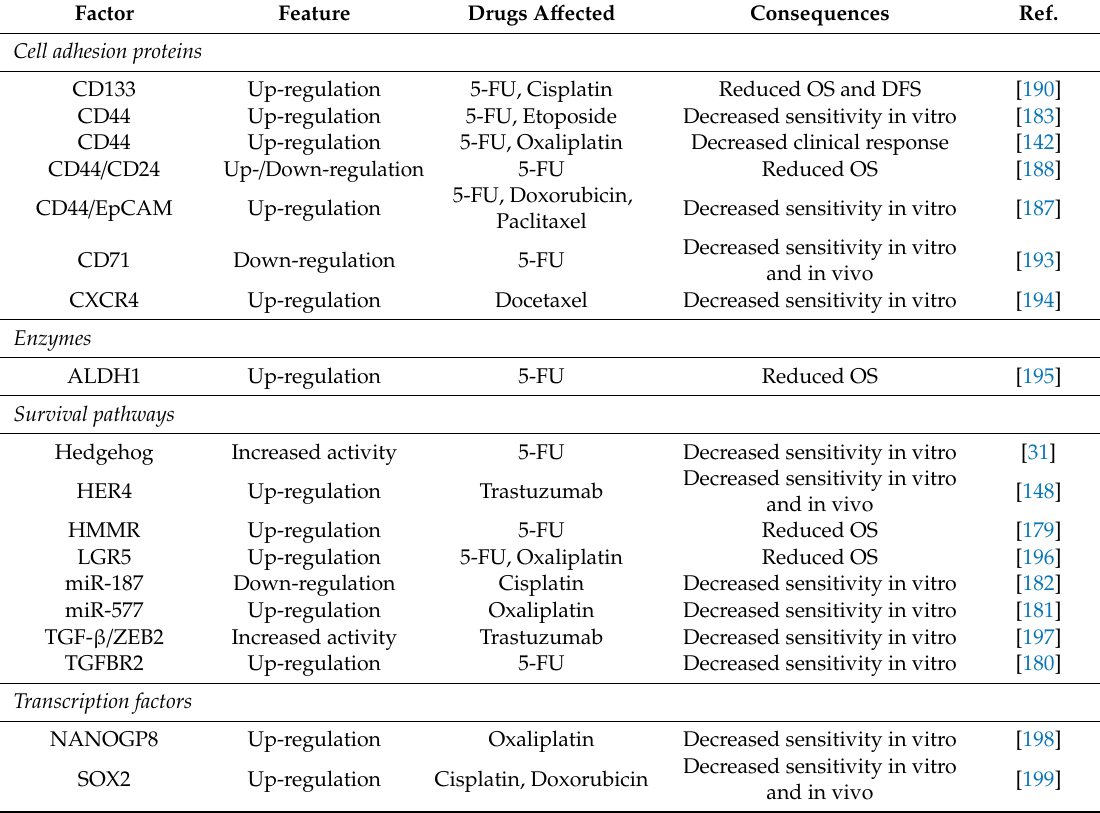
Table 7. Mechanisms of chemoresistance type 7 (MOC-7) to drugs used in the treatment of